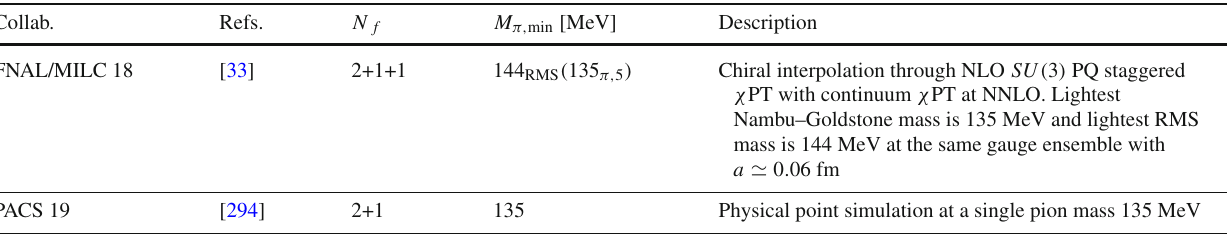
Table 104 Chiral extrapolation/minimum pion mass in determinations of f + ( 0 ) . The subscripts RMS and π, 5 in the case of staggered fermions indicate the root-mean-square mass and the Nambu–Goldstone boson mass, respectively Collab.